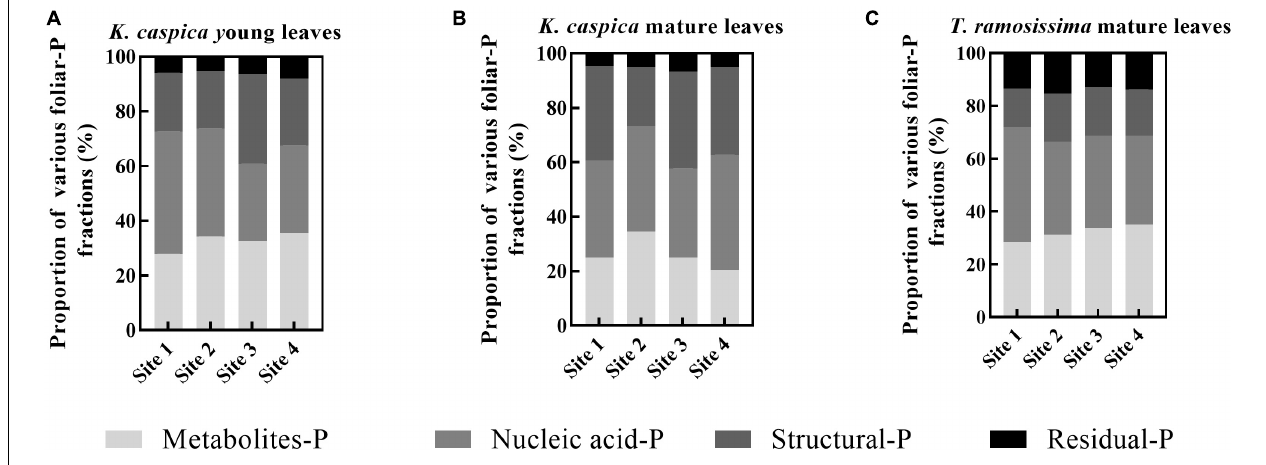
FIGURE 4 | The allocation proportions of foliar-P fractions of two plant species at different environment-P sites. The allocation proportions of foliar-P fractions of K. caspia young leaves (A) , K. caspia mature leaves (B) , and T. ramosissima mature leaves (C) ,